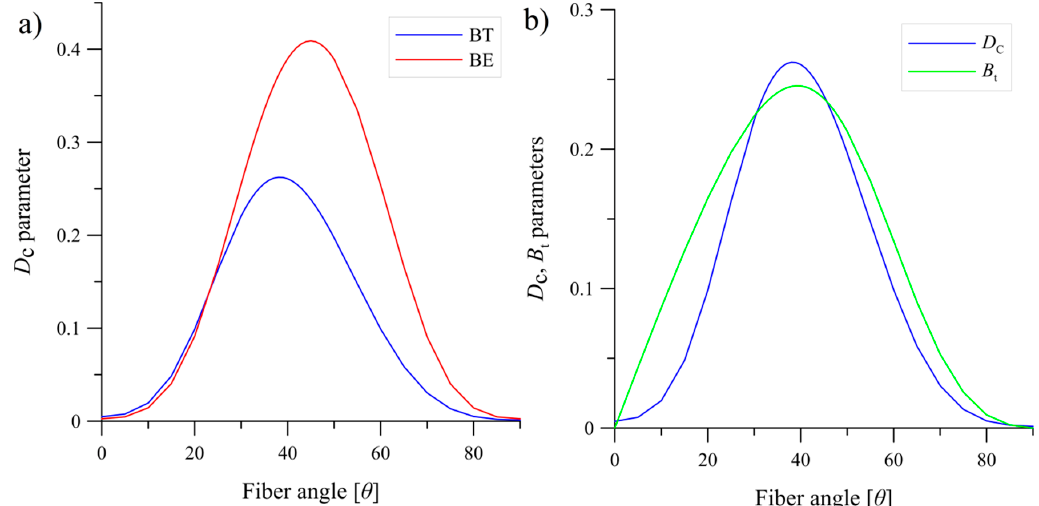
Figure 2. Non-dimensional parameters: ( a ) values of the D C parameter calculated for different fiber angles θ for the bending-twisting and the bending-extension laminates, ( b ) values of the D C and B t parameters calculated for different fiber angles θ for the bending-twisting laminate.